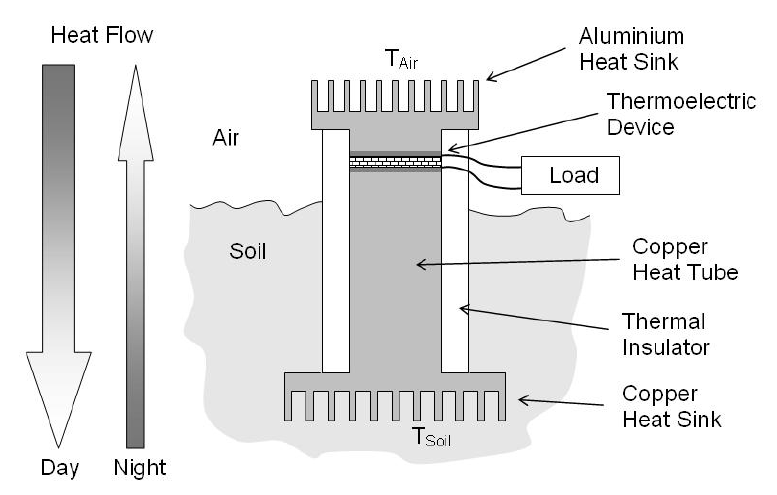
Figure 14. Simplified Diagram of Temperature harvesting